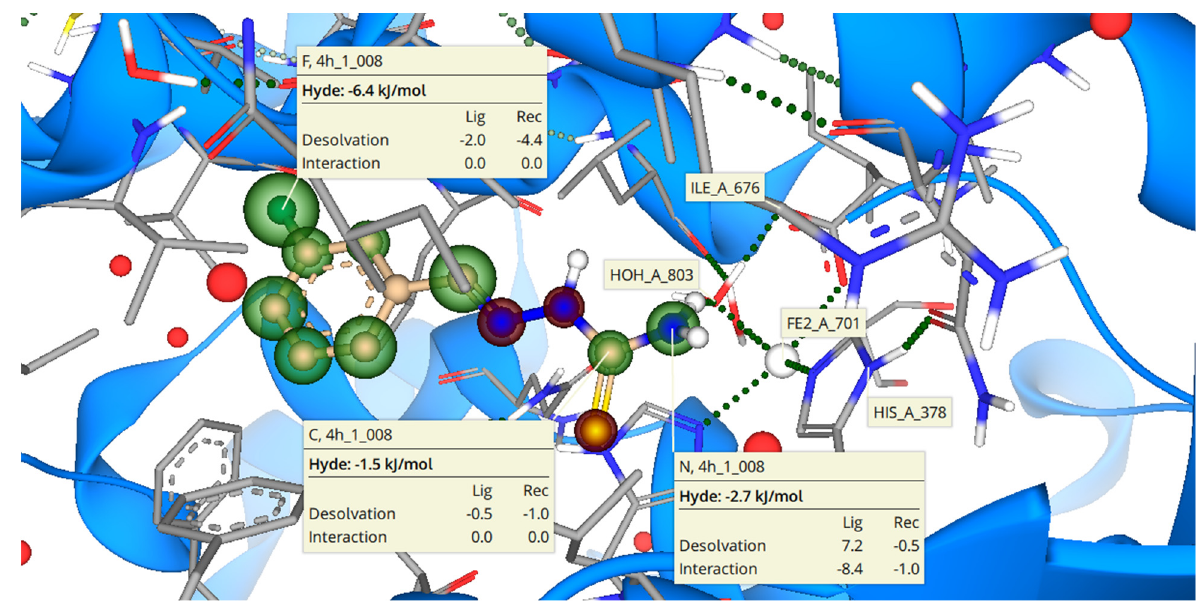
Figure 4. Putative binding mode of 3h (most active compound, peach colored) in the active site pocket of 15-lipoxygenase (amino acid residue in grey color). The red-colored coronas depict unfavorable features, whereas green-colored coronas indicate favorable contributions and colorless coronas show no contribution of the structural components.